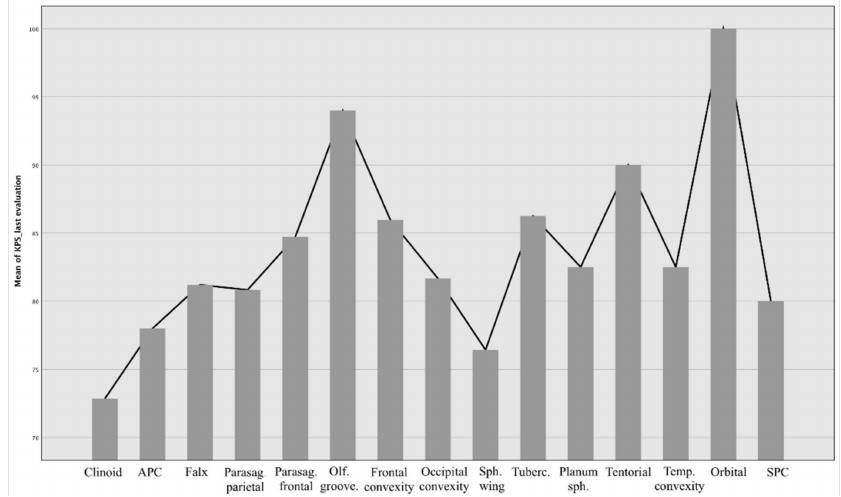
Figure 8. The same measures of outcome (using KPS value), reported at last evaluation (after 12 months at least).